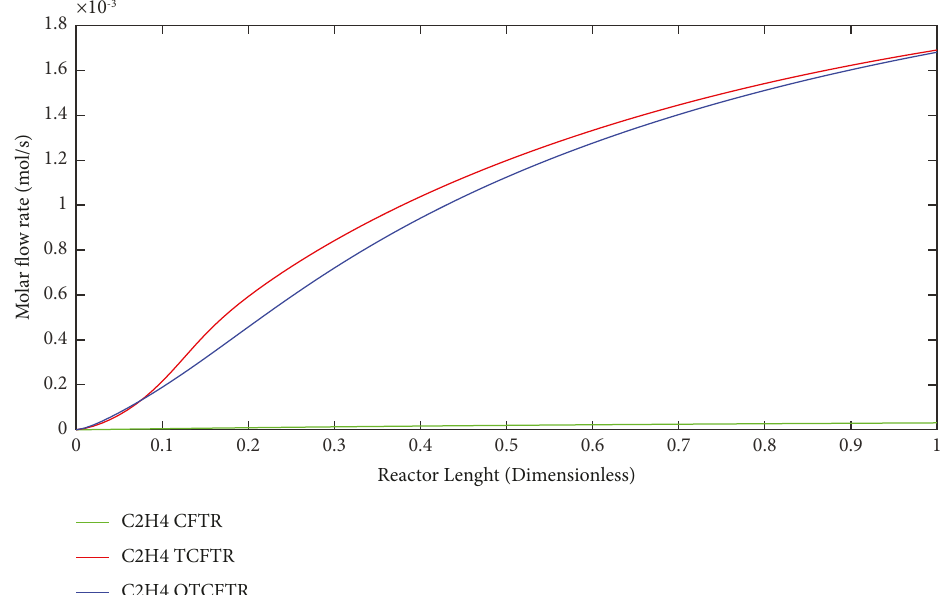
Figure 16: Comparison of the molar flow rate of ethylene in the exothermic part of the reaction for CFTR, TCFTR, and OTCFTR.